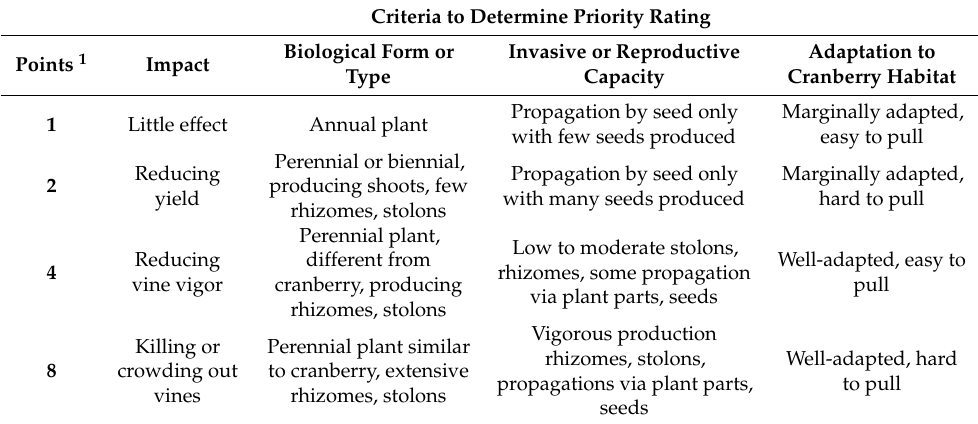
Table 1. Criteria and points associated with determination of the priority rating of a weed in cranberry production systems according to Neron et al., 2013 and Sandler et al.,